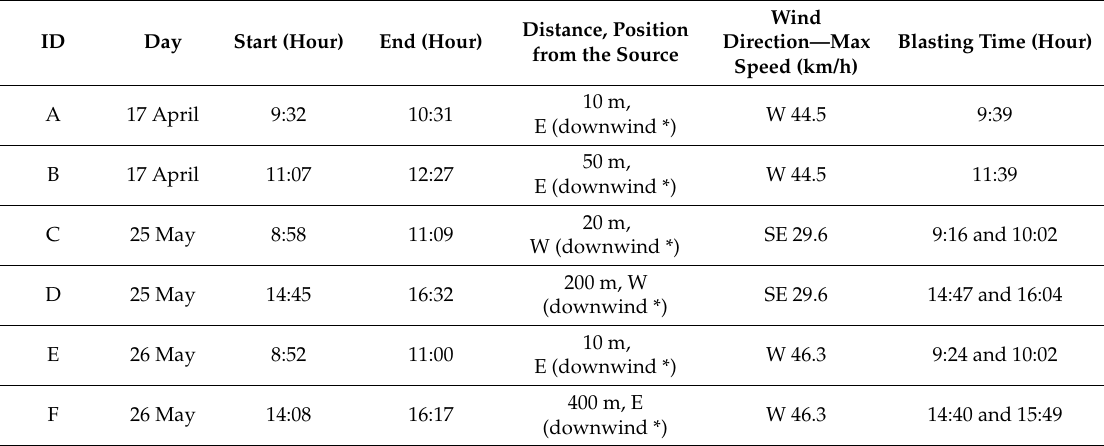
Table 1. Sampling time, sampler position and meteorological conditions during the ammunition blasting campaign.